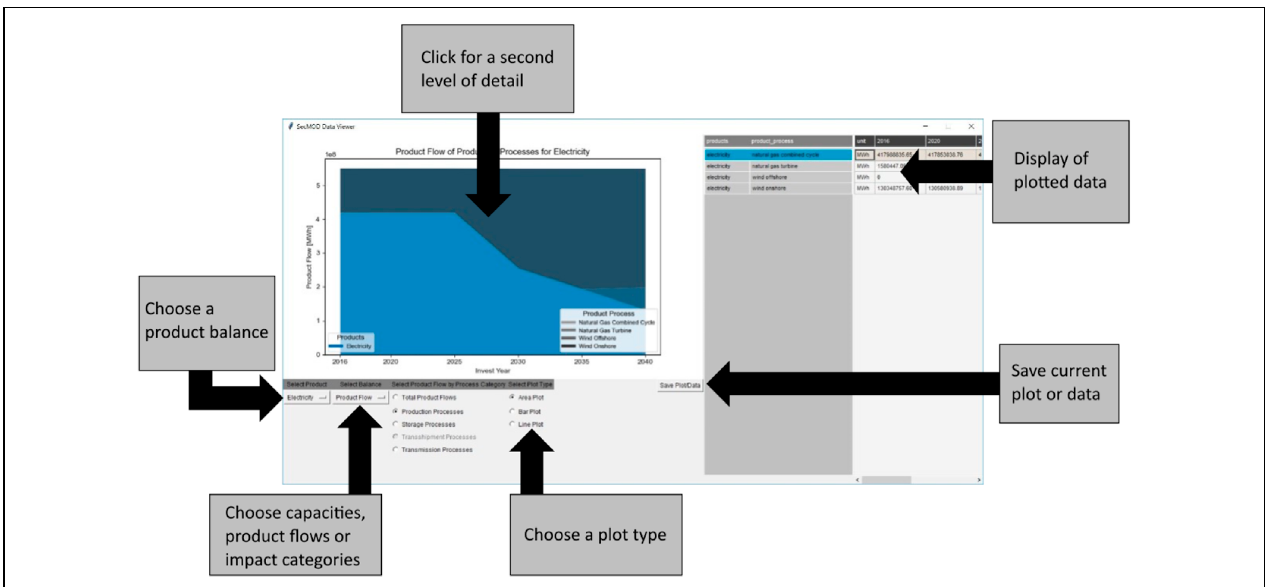
FIGURE 4 | Graphical user interface for the result assessment of